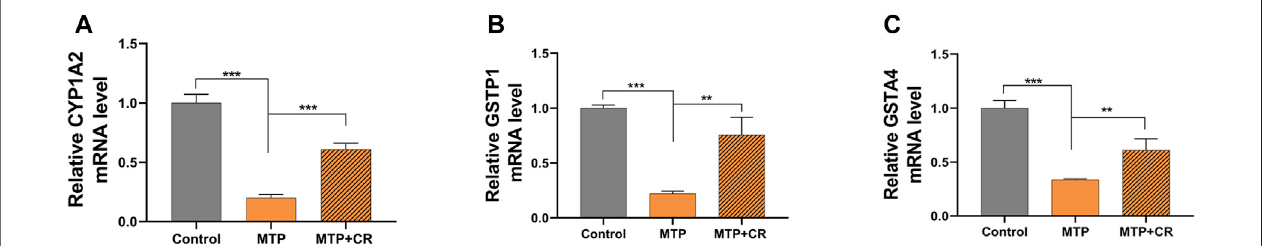
FIGURE 13 | Con fi rmation of mRNA expression by qRT-PCR (A) the CYP1A2 mRNA level; (B) the GSTP1 mRNA level; (C) the GSTA4 mRNA level. ** p < 0.01,*** p < 0.001 vs MTP.